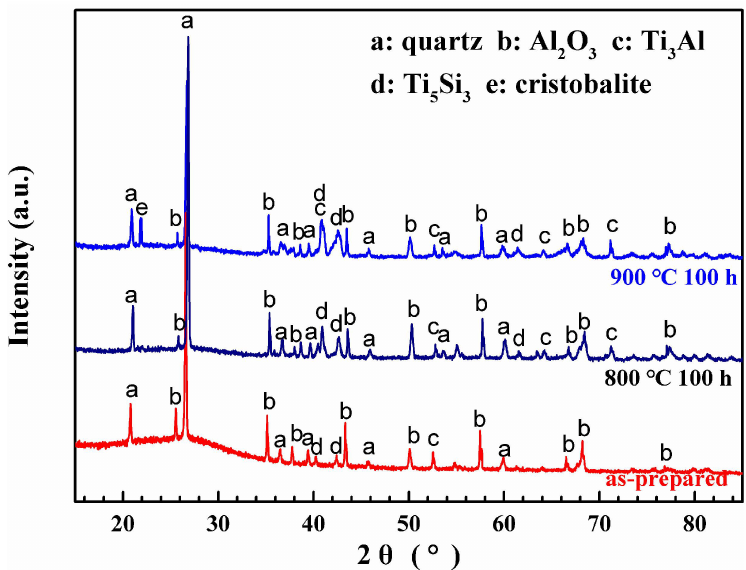
Figure 3. XRD patterns of the composite coating as prepared and after oxidation.